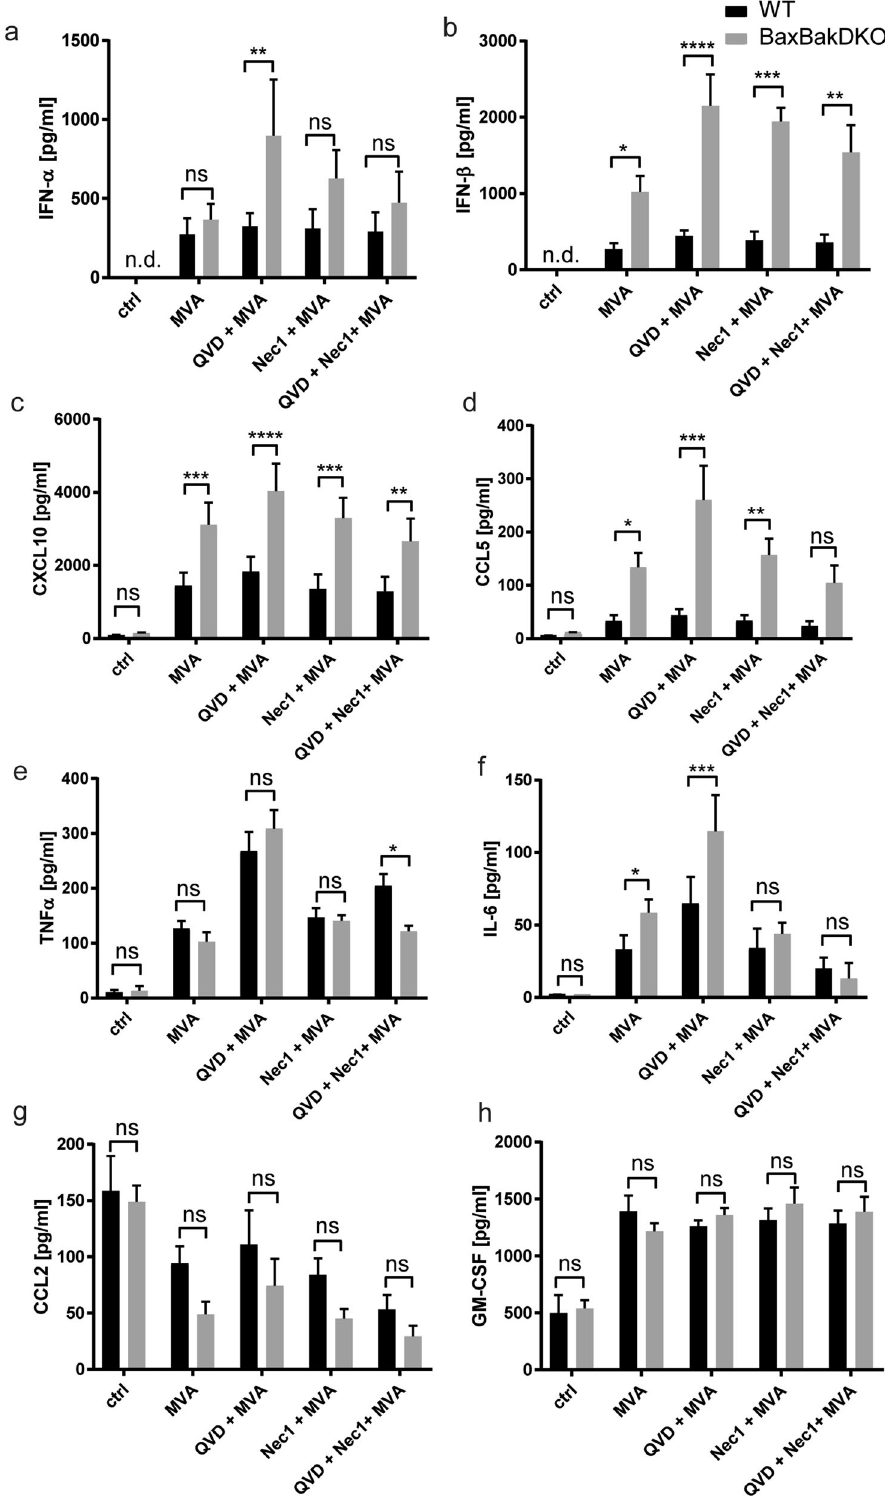
Fig. 5 Modulation of the cytokine response of MVA-infected macrophages by distinct cell death-pathways. a – h Supernatants of d7 differentiated wt (black bars) or Bax/Bak-DKO (gray bars) Hoxb8 macrophages infected with MVA at a MOI of 2 were collected after 22 h. Some samples were treated with inhibitors QVD (20 µM) and Nec-1 (10 µM) alone or in combination as indicated. Samples were analysed for the cytokines indicated by a bead-based assay (Legendplex, antivirus response panel, Biolegend). Shown are the means/SEM of n = 3 independent experiments. * p < 0.05; ** p < 0.01, *** p < 0.001, **** p < 0.0001; ns nonsigni fi cant ( p ≥